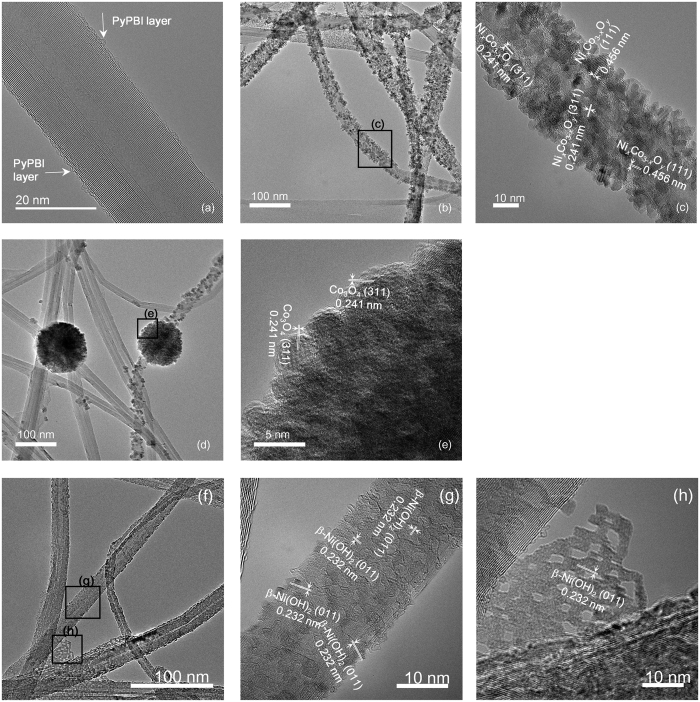
Morphologies of metal oxides deposited on MWNT-PyPBI.TEM images of (a) MWNT-PyPBI, (b,c) MWNT-PyPBI-NixCo3−xO4, (d,e) MWNT-PyPBI-Co3O4, and (f,g,h) MWNT-PyPBI-Ni(OH)2; the TEM images of the black rectangle-selected area in (b,d,f) obtained in larger magnification are also shown in (c,e,g,h).